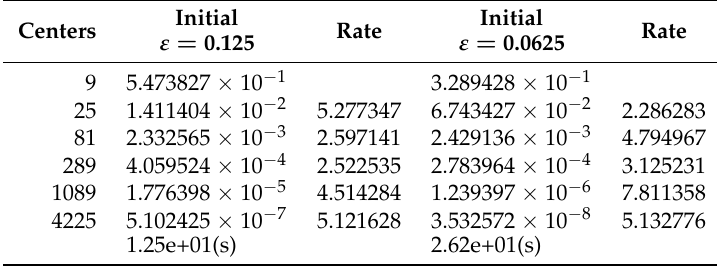
Table 12. H-RBFs collocation of example 2: with initial 0.125 and